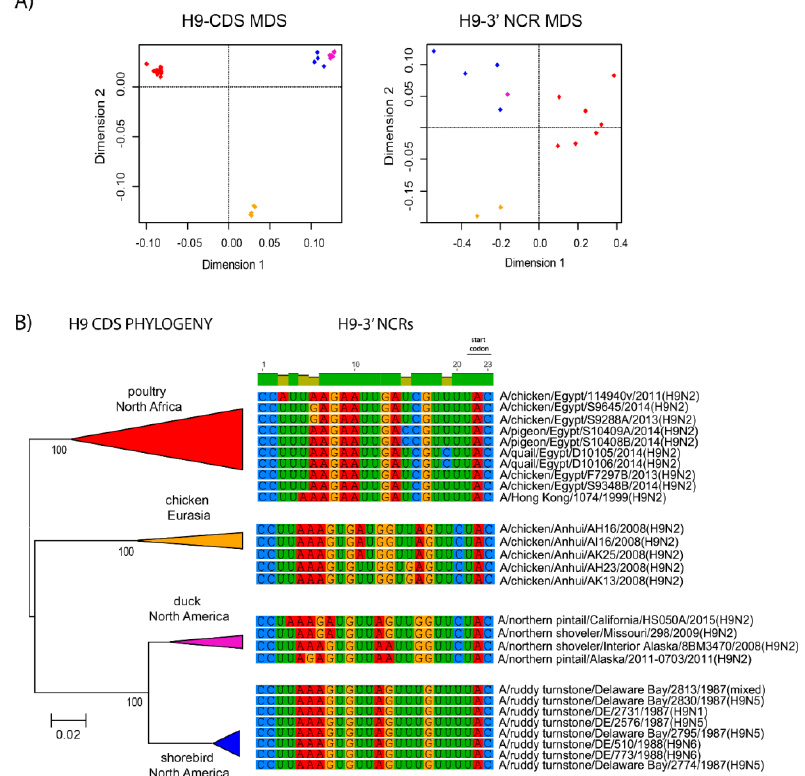
Figure 4. Relationships among H9 3 (cid:48) NCR and CDS regions for viruses from different host species and geographic locations. The multi-dimensional analysis (MDS) scatter plots ( A ) are based on the pairwise genetic distance matrices from the multiple alignments of complete CDS regions and 3 (cid:48) NCRs. Each dot represents a virus, colored according to their origins as indicated on the CDS-based phylogenetic tree ( B ). Alignments of the 3 (cid:48) NCRs, shown corresponding to the genomic RNAs, from the viruses used in the analyses are next to the CDS-based neighbor-joining tree for these